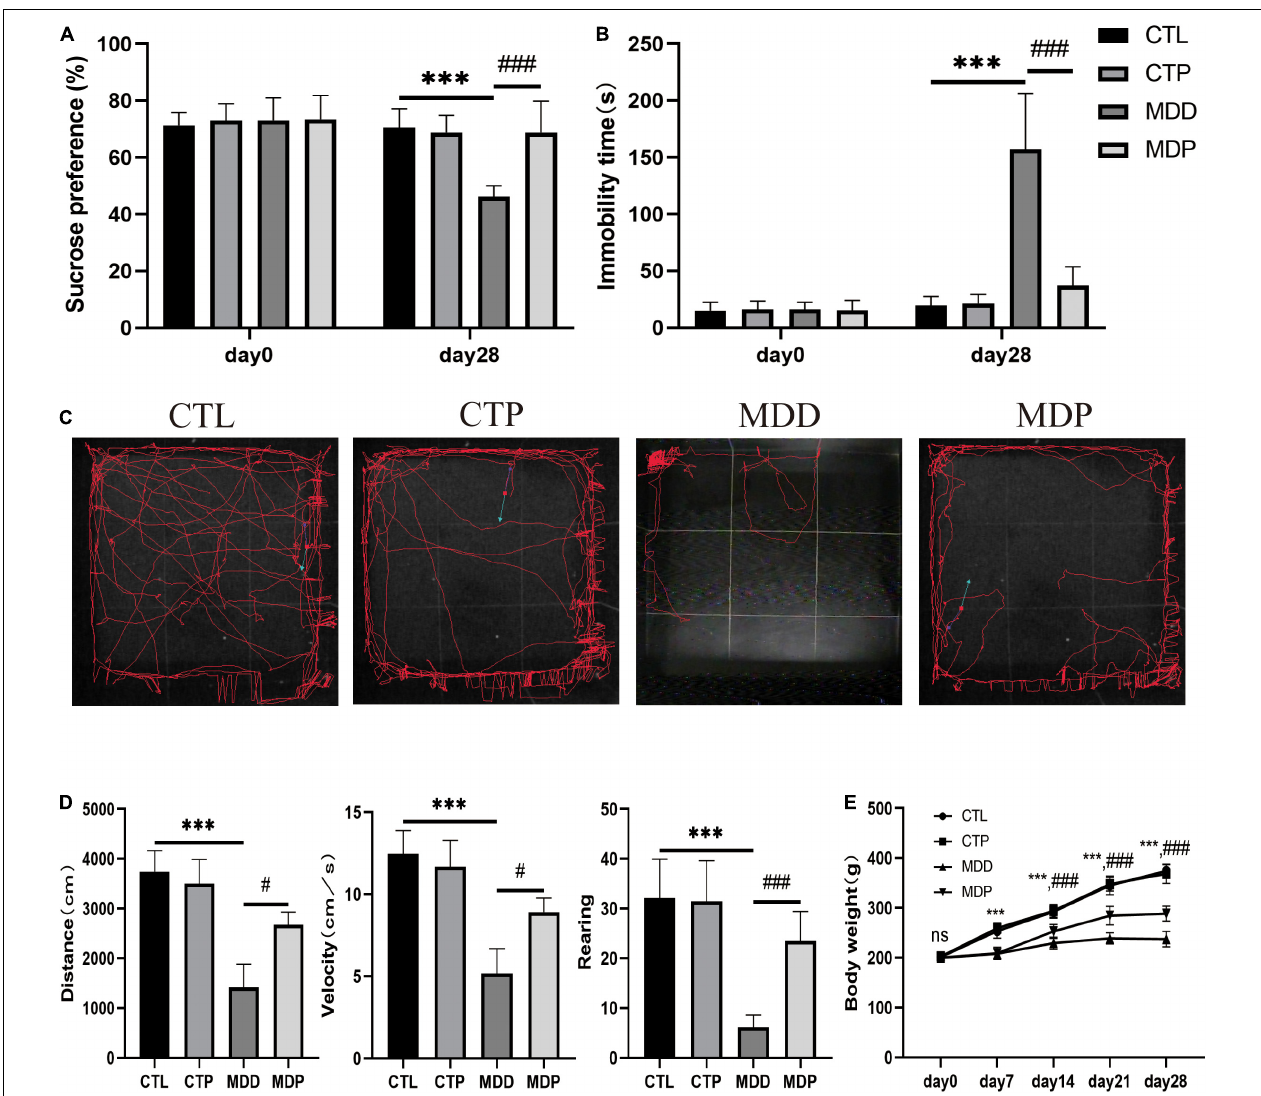
FIGURE 1 | Behavioral measurements. (A) Sucrose preference before and after CUMS. (B) Immobility time before and after CUMS. (C) Typical images of the trajectory after CUMS. (D) Traveling distance, velocity, and number of rearing events. (E) Body weight during the experiment. n = 20 per group. *** p < 0.001 vs. CTL; # p < 0.05, ### p < 0.001 vs.